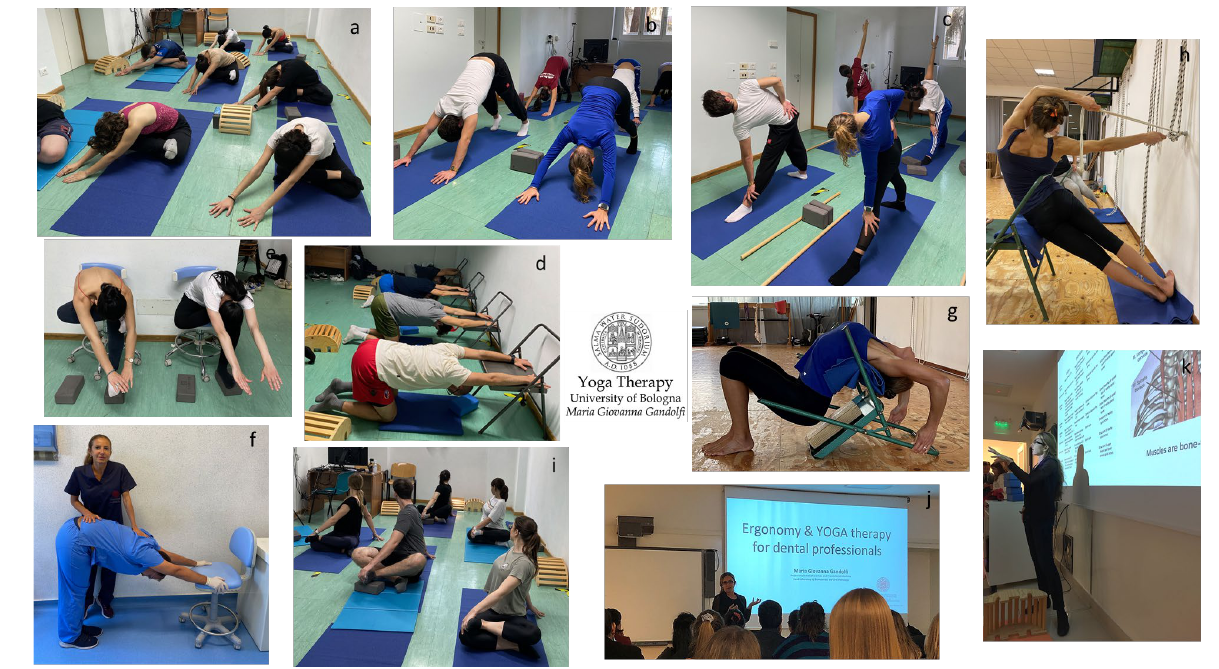
Figure 9. The figure shows āsana for the hips ( a , c , e , h , i ), shoulders ( b , d , f , g ), and back of the